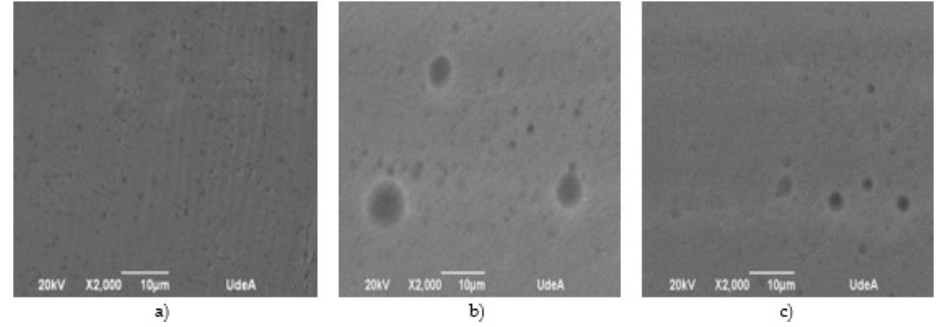
Figure 5. SEM micrographs for chitosan biofilms: ( a ) commercial, ( b ) sample 2 ( c ) and sample